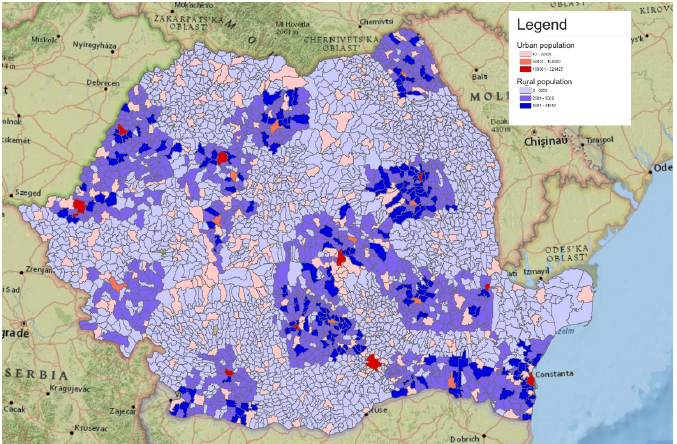
Figure 3: Urbanization index